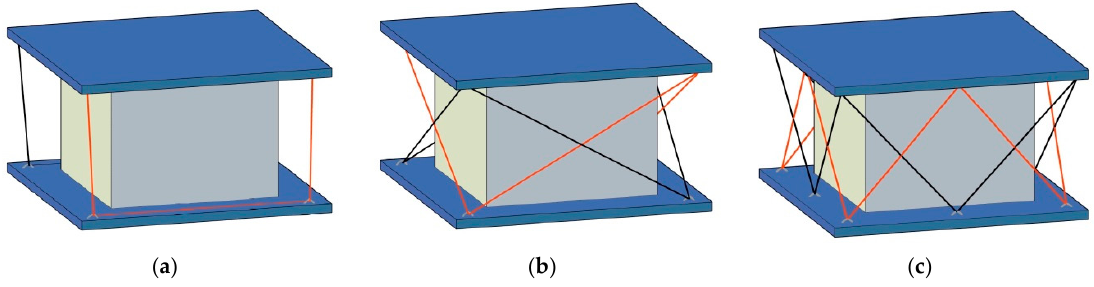
Figure 6. ( a ) Straight, ( b ) cross and ( c ) double-cross configuration of shape memory alloy (SMA)-LRB.